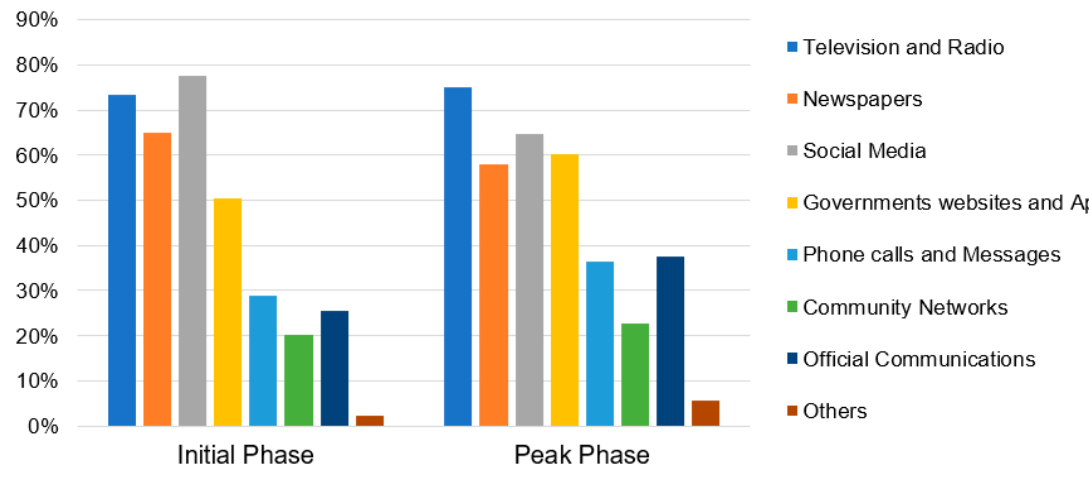
Figure 4. Key Information Sources identified by the survey respondents for COVID-19.